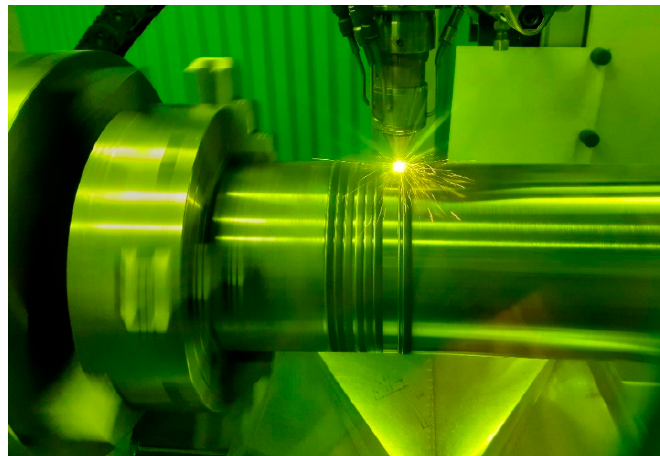
Figure 12. Photograph of a thin-DED test on a roller.